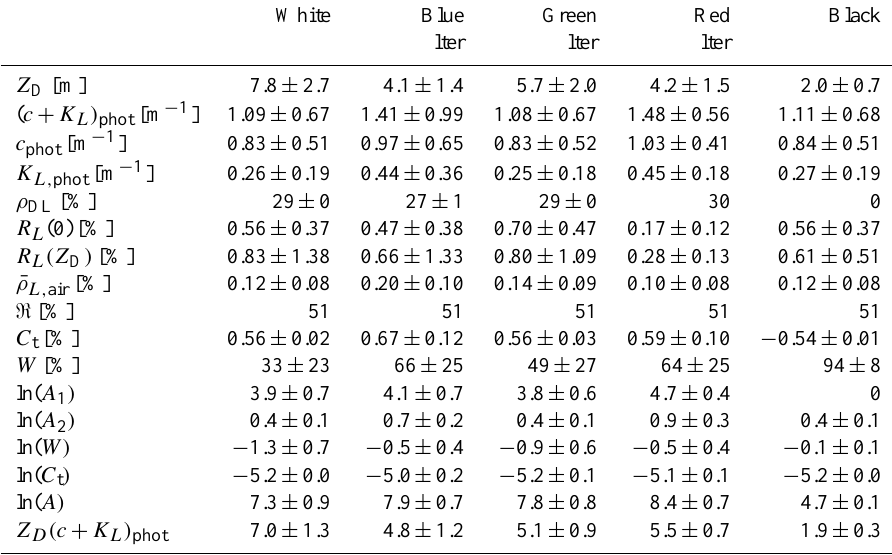
Table 3. Mean value and standard deviation of the different quantities and terms of Eqs. (19)–(20) in the Oslofjord and Skagerrak, for the 30cm white and black disks. Colour filters are for the white disk. Recordings of radiance and irradiance at 32 stations have been